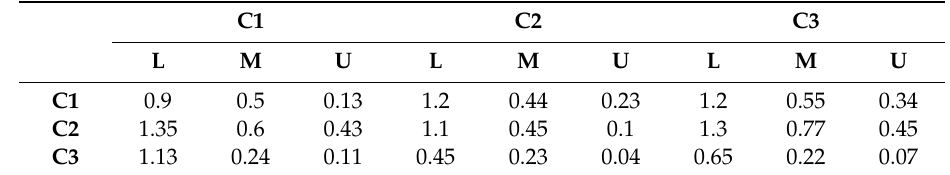
Table 6. Total fuzzy relation matrix for the main categories.